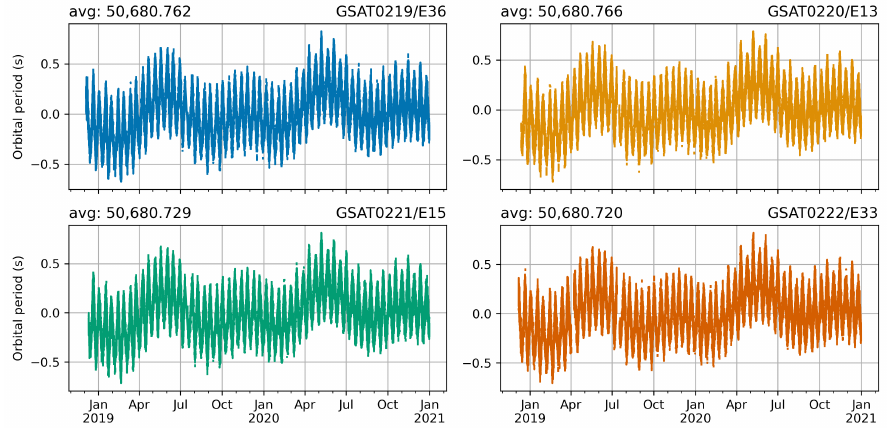
Figure 5. Orbital repeat period variations of the Galileo L10 satellites from the beginning of the navigation data transmission to December 2020. [Unit: seconds].